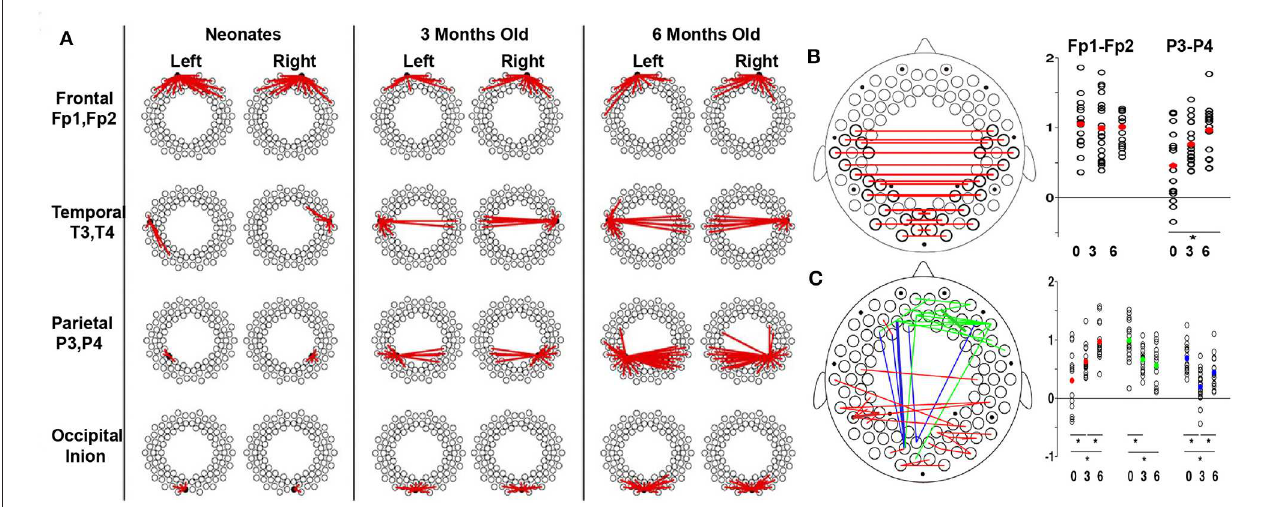
FIGURE 4 | Developmental trajectories of functional connectivity. (A) Development of the connectome with seeds in different brain regions. The dots represent the measurement channels, and the red lines represent correlations higher than 0.5. (B) Development of the connectome in homologous channels. Red lines represent the connections exhibiting significant changes. The scatter plots show z scores in frontal (Fp1–Fp2) and parietal (P3–P4) pairs, with the red dot indicating the average values. (C) Increase (red), decrease (green), and U -shaped (blue) changes in the connectome across development. The normalized connectivity grouped by the change patterns are displayed next to the brain template, in which the dots with corresponding colors represent the average connectivity of corresponding change patterns. For (B,C) , the significant differences are labeled with asterisks ( p < 0.05, post-hoc tests, Tukey’s HSD). These figures are adapted from Homae et al.